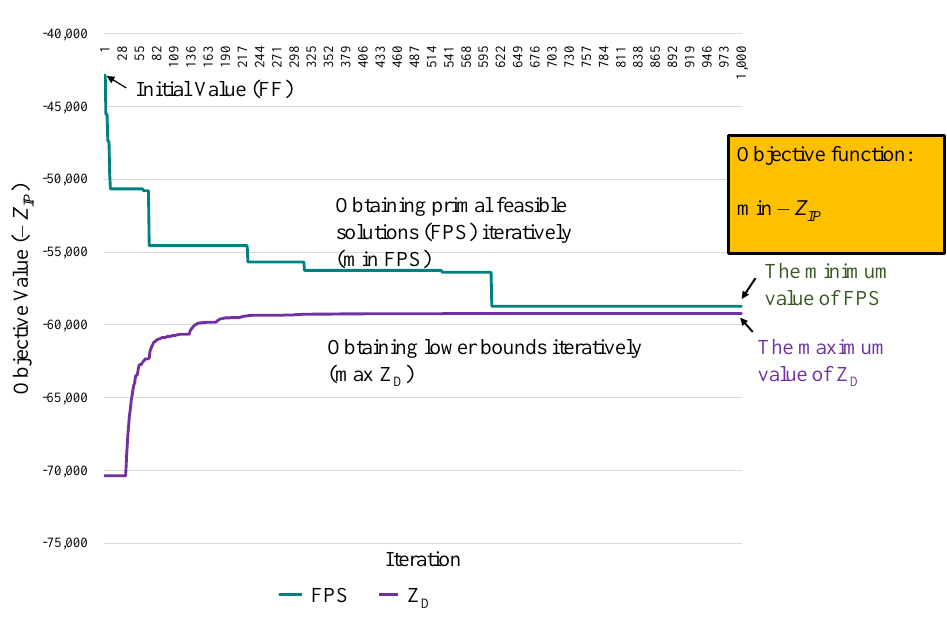
Figure 5. Obtaining primal feasible solutions and the lower bound (LB)